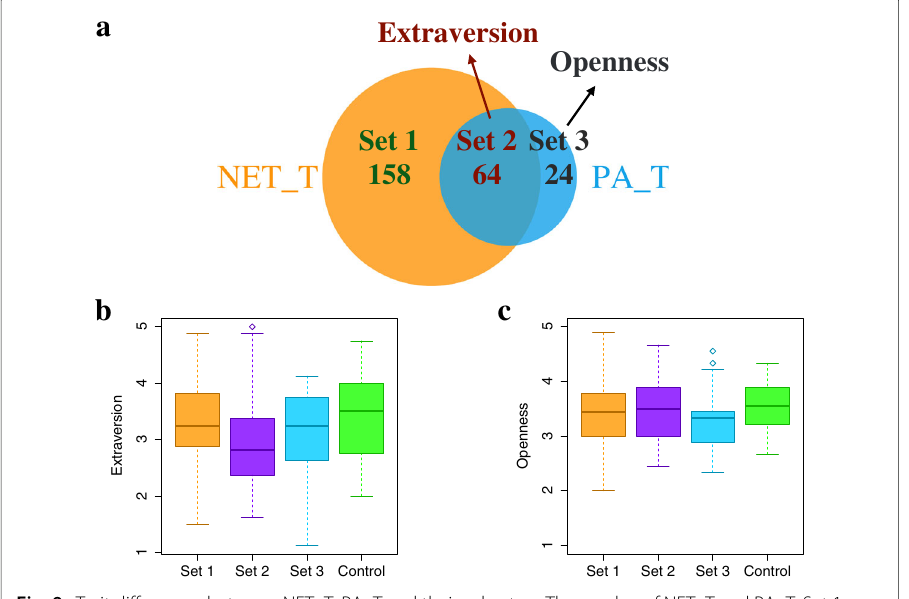
Fig. 9 Trait differences between NET_T, PA_T and their subsets. a The overlap of NET_T and PA_T. Set 1 denotes users who are in NET_T but not in PA_T. Set 2 denotes users who are in both NET_T and PA_T. Set 3 denotes users who are in PA_T but not in NET_T. b Boxplots of extraversion scores of user sets 1-3 and a control set, where the latter denotes users from CoU who are not in any of sets 1-3. c Boxplots of openness scores of the same user sets as in panel